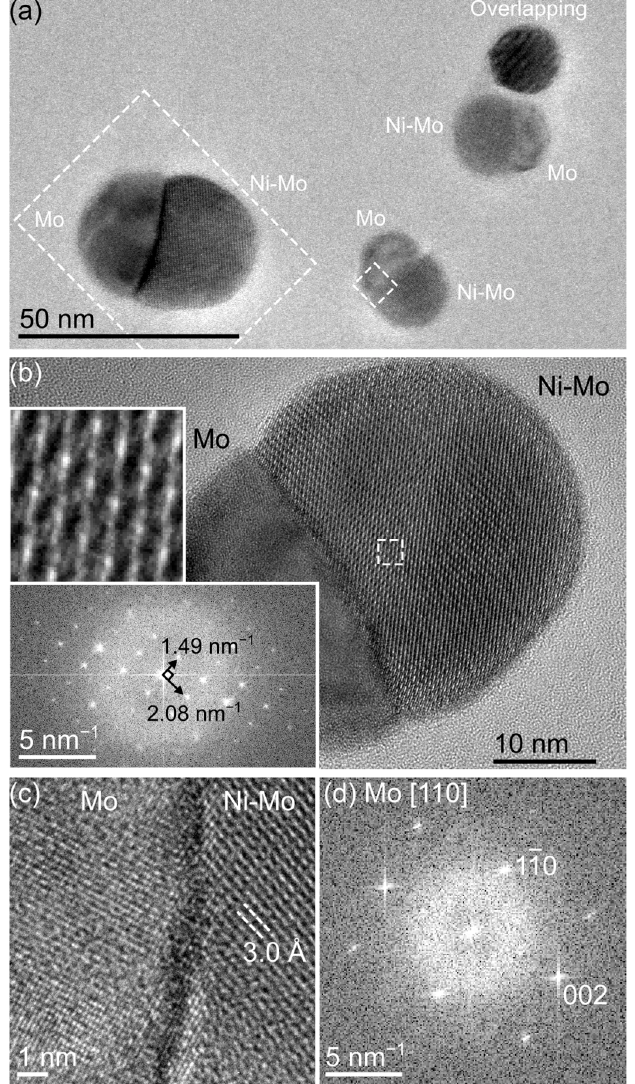
Figure 1. ( a ) Overview of an as-deposited Ni-Mo sample on an amorphous SiN substrate. The two phases are indicated for each particle. The marked regions are shown in more detail in subsequent panels. ( b ) HR-TEM image of the larger particle marked in ( a ), with insets showing the phase contrast pattern from a 2.5 × 2.5 nm 2 region and corresponding diffractogram from the Ni-Mo phase (corresponding to the [001] zone of Mo 3 Ni 2 N, as described later). ( c ) HR-TEM image showing the interface between the two phases from the smaller particle marked in ( a ). The pure Mo phase shows lattice spacings corresponding to pure bcc Mo in a [110] viewing direction, as further shown by the diffractogram in ( d ) (excluding the Ni-Mo